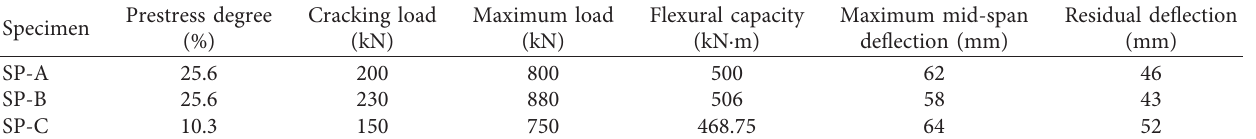
Table 3: Summary of test